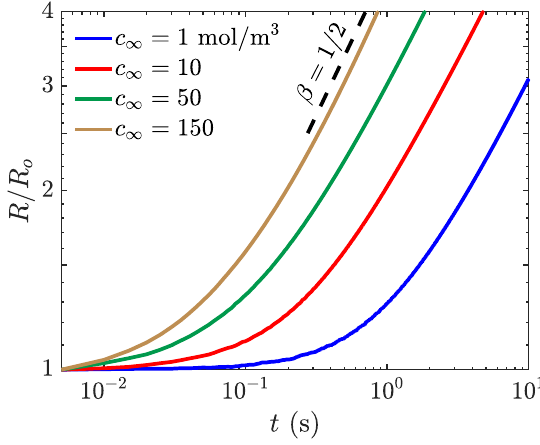
Figure 6. Simulation of bubble growth as a function of time with a liquid concentration c ∞ of 1 (blue), 10 (red), 50 (green), and 150 mol m − 3 (yellow). The obtained bubble radius as a function of time, R ( t ) t β , is normalized by the initial bubble radius. A power law fitting for R ( t ) ∼ t 0.5 (black dashed) is presented for